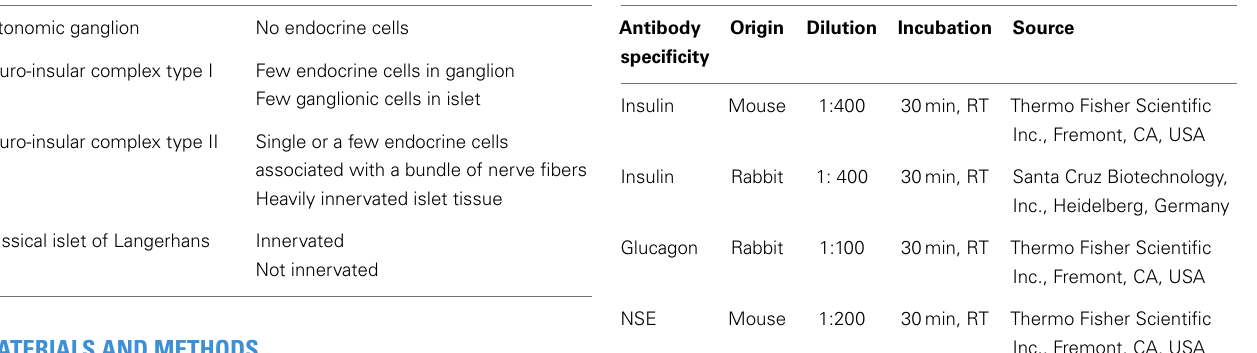
Table 1 |The classification of pancreatic neuroendocrine structures (4). Table 2 | Panel of antibodies used.